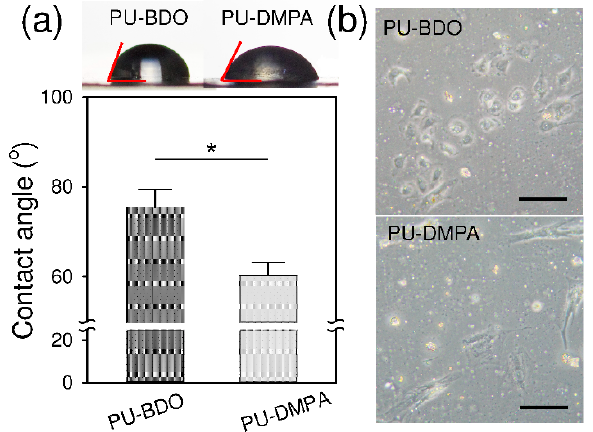
Figure 5. ( a ) Representative photographs of water droplets on the surface of the PU-BDO and the PU-DMPA cast films and the comparison of their contact angles. ( b ) Morphology of HUASMCs adhered on the surface of the PU-BDO and the PU-DMPA cast films after one day of culture; scale bar = 100 µm. * denotes p < 0.05.